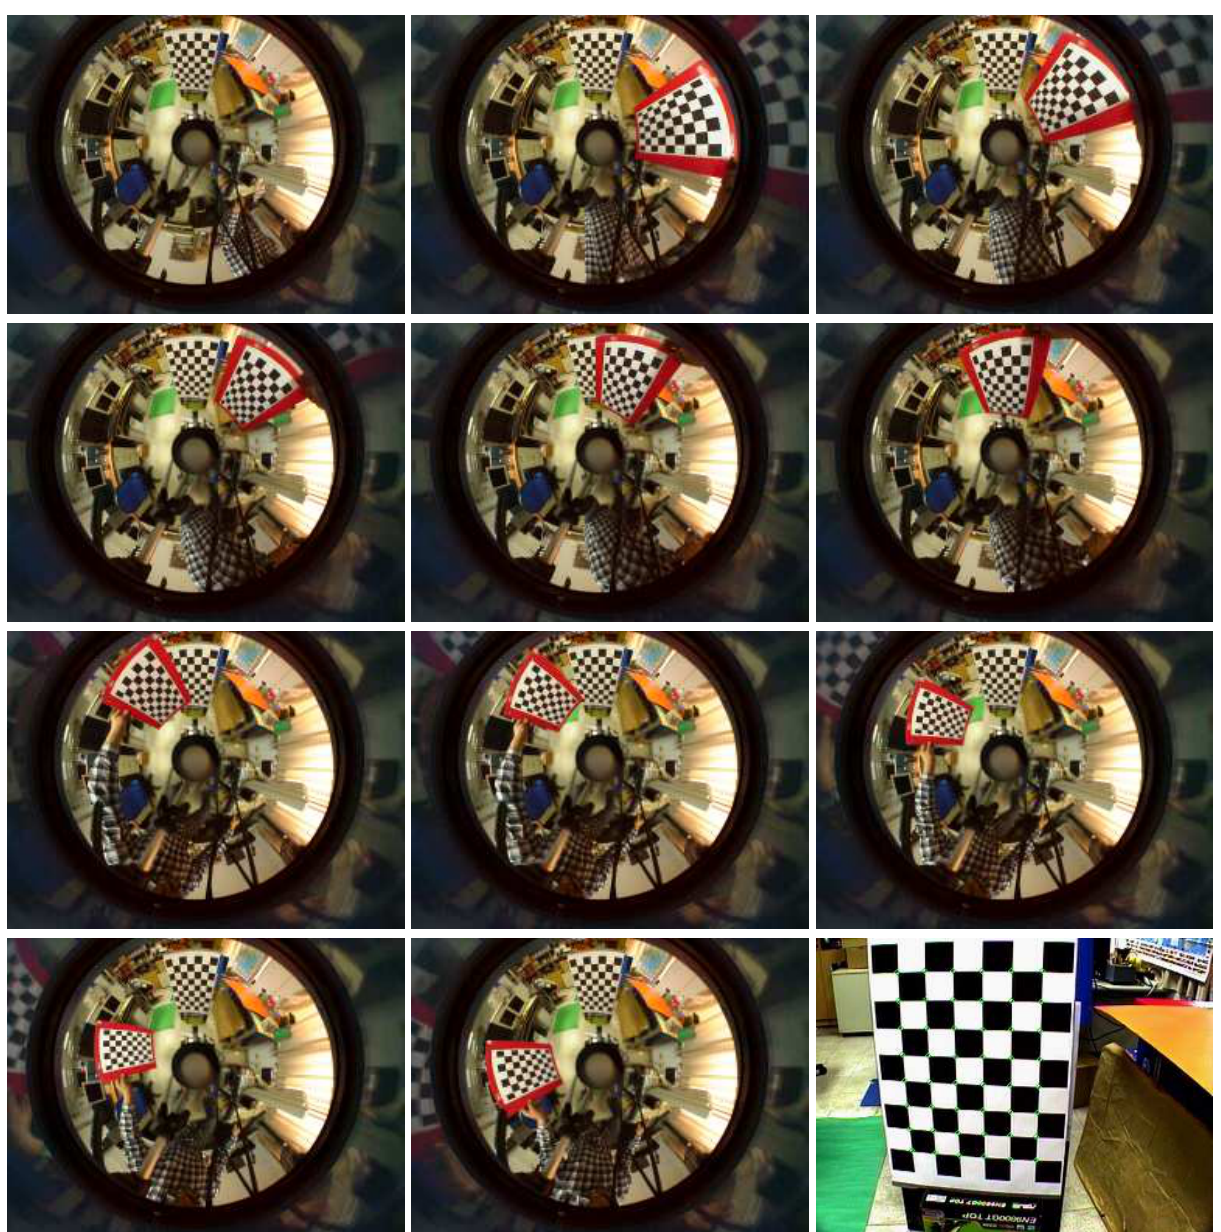
Figure 6. The images captured by the omnidirectional and perspective cameras are used for system calibration. The checkerboard pattern shown in the perspective and the first omnidirectional image served as the world coordinate frame of the camera